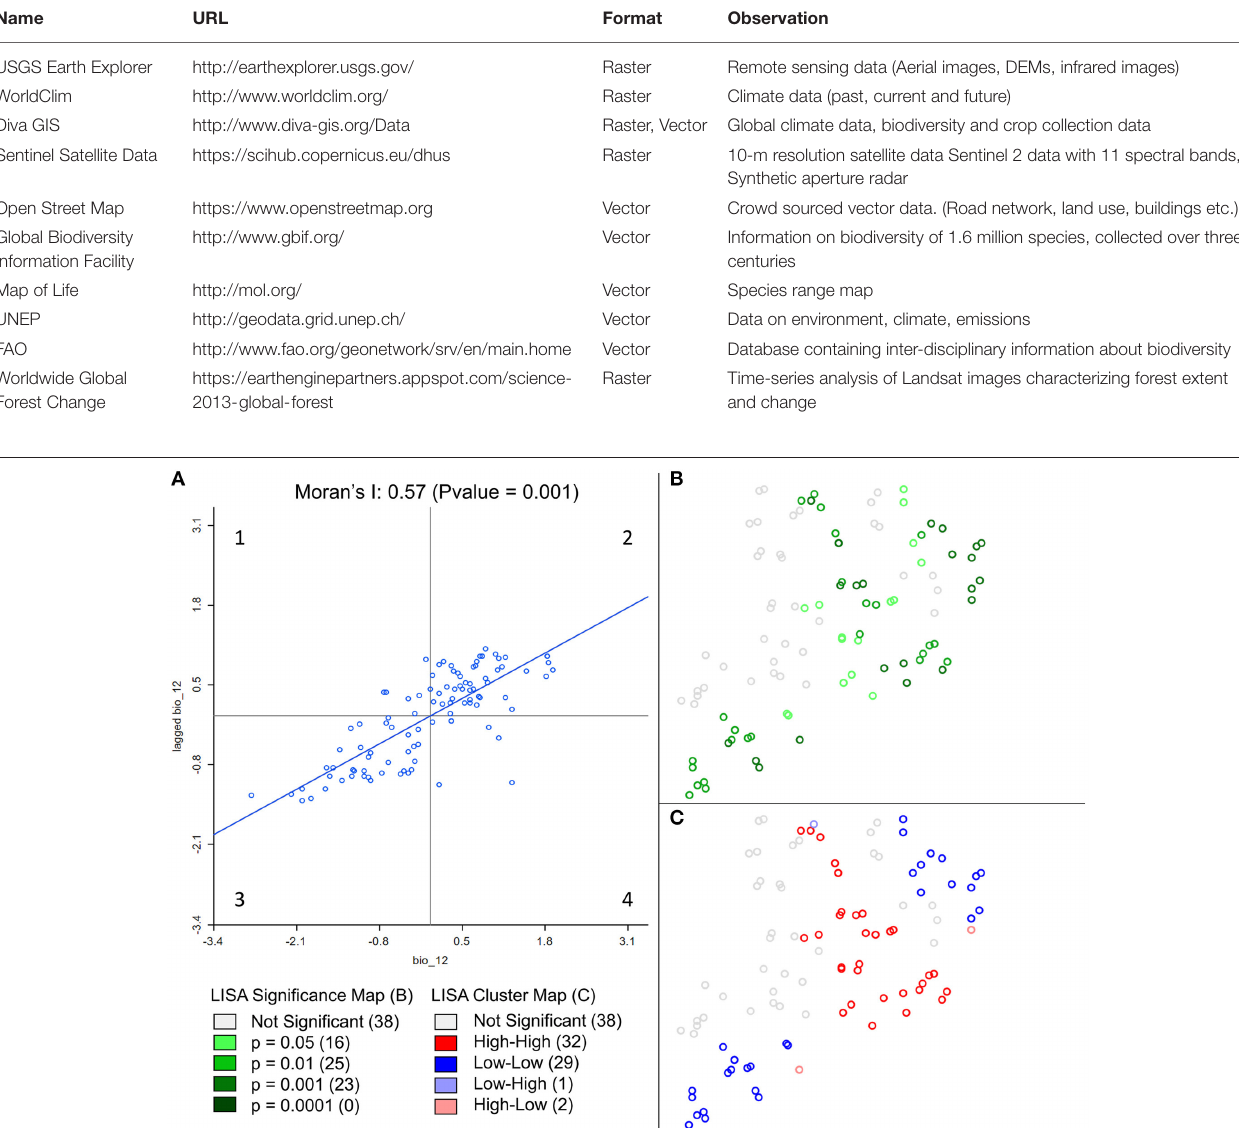
such as the WorldClim dataset (Hijmans et al., 2005). These data are often delivered as continuous grids and their spatial resolution (i.e., area covered by a pixel) typically varies between 1 and 10 km 2 . For more local or regional databases, however, national agencies are the most valuable sources ( Box 1